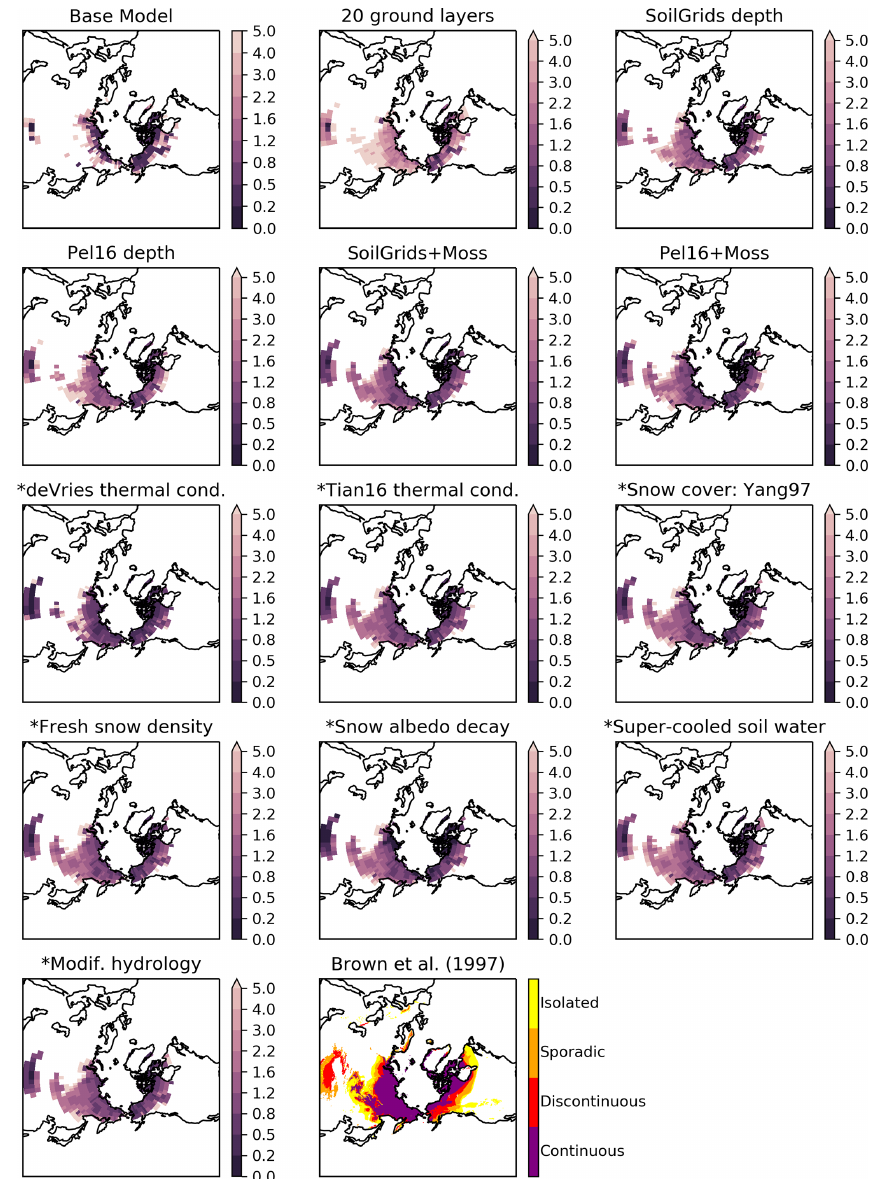
Figure 2. ALTs in meters for experiments listed in Table 1 alongside the permafrost map of Brown et al. (1997) (bottom right). Experiments with an asterisk prefixing their name use a model configuration based on the SoilGrids+Moss setup. All experiments shown here use CRUNCEP for the meteorological